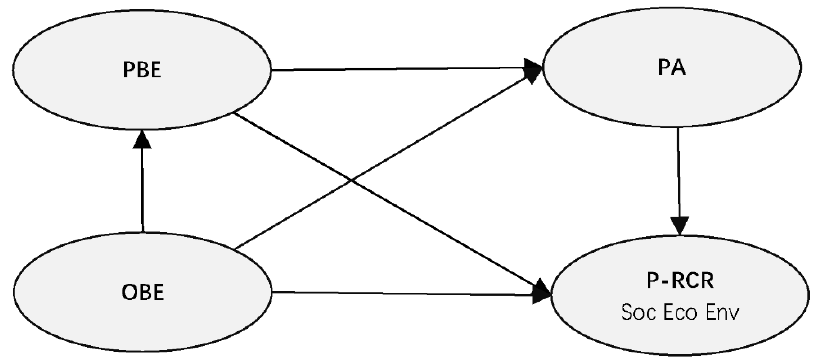
Figure 1. Theoretical framework of the BE-P-RCR relationship. PBE = perceived built environment; OBE = objective built environment; PA = place attachment; P-RCR = the proactive aspect of rural community resilience; Soc = social dimension of P-RCR; Eco = economic dimension of P-RCR; Env = environmental dimension of P-RCR.